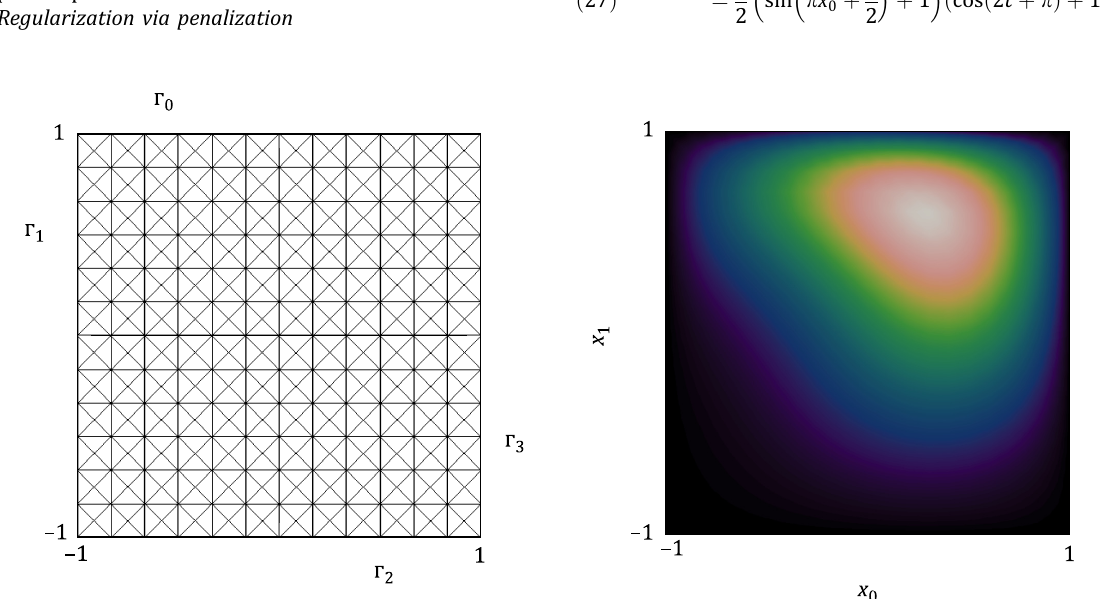
Figure 1. Illustration of the domain, the arrangement of the boundary segments, a triangulation with N h = 12, and a snapshot of an approximation to the internal convection – diffusion as described in Test Case 1 at time t =